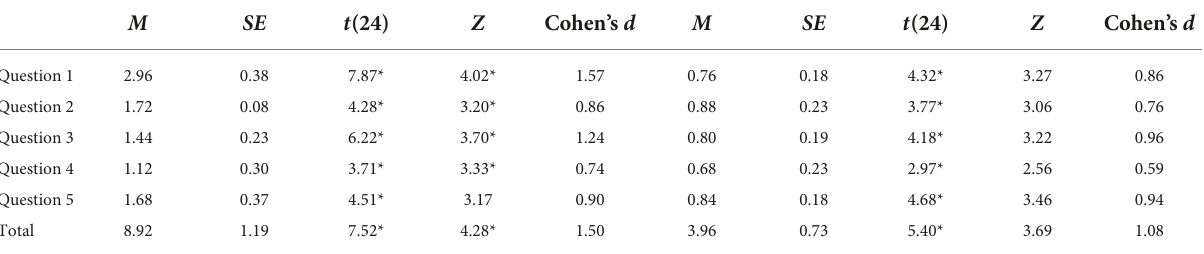
TABLE 3 Paired t -test results.